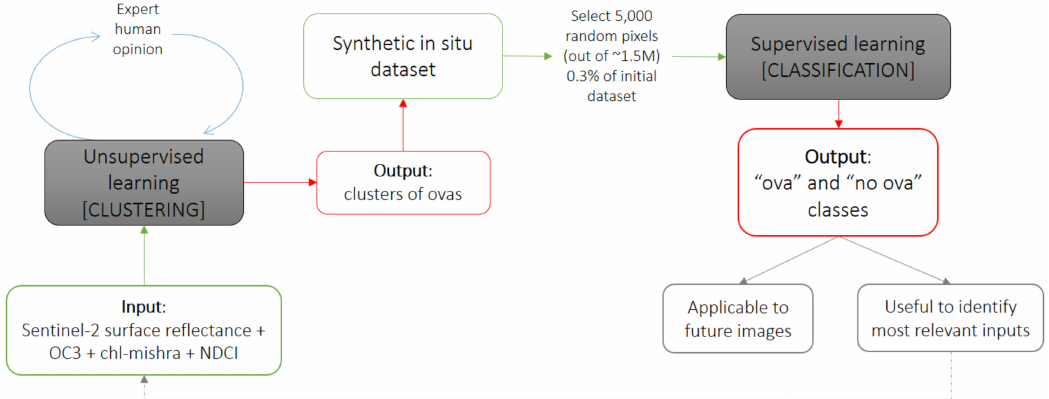
Figure 2. Flow diagram of the algorithm